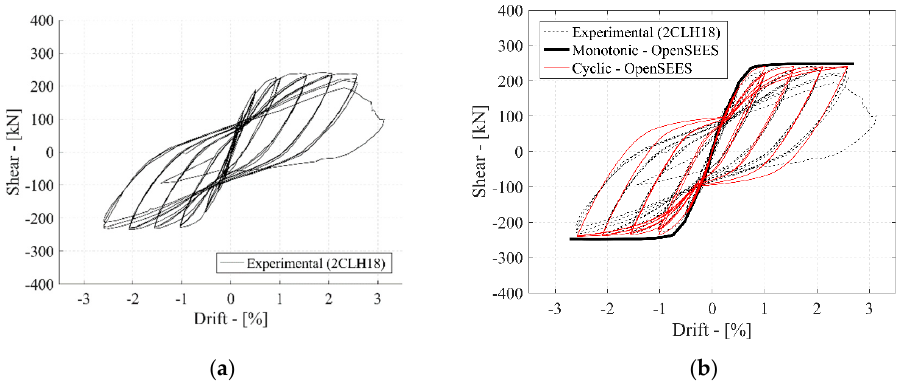
Figure 12. Specimen 2CLH18 : ( a ) Experimental behaviour. ( b ) Comparison of numerical cyclic response with experimental results.